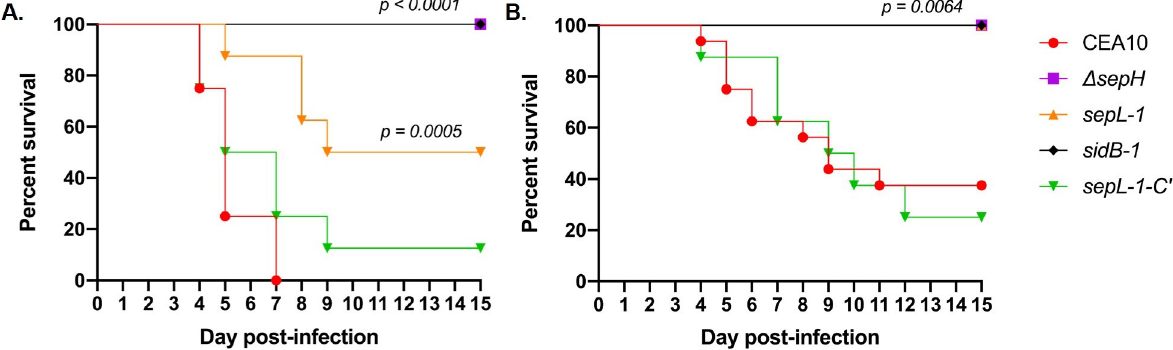
Fig 7. SIN kinase activity is required for virulence in mouse models of invasive aspergillosis. Mice (n = 8 / group for Δ sepH , sepL-1 , sidB-1 and sepL-1-C ’; n = 16 for CEA10) were chemotherapeutically immune suppressed with both cyclophosphamide and triamcinolone acetonide (A) or triamcinolone acetonide alone (B) and inoculated with 1 x 10 5 conidia of the indicated strain. Survival was followed for 15 days post-inoculation. Statistical analyses (Mantel-Cox Log-rank test) identified significantly reduced virulence for all SIN kinase mutant strains vs . the CEA10 control.